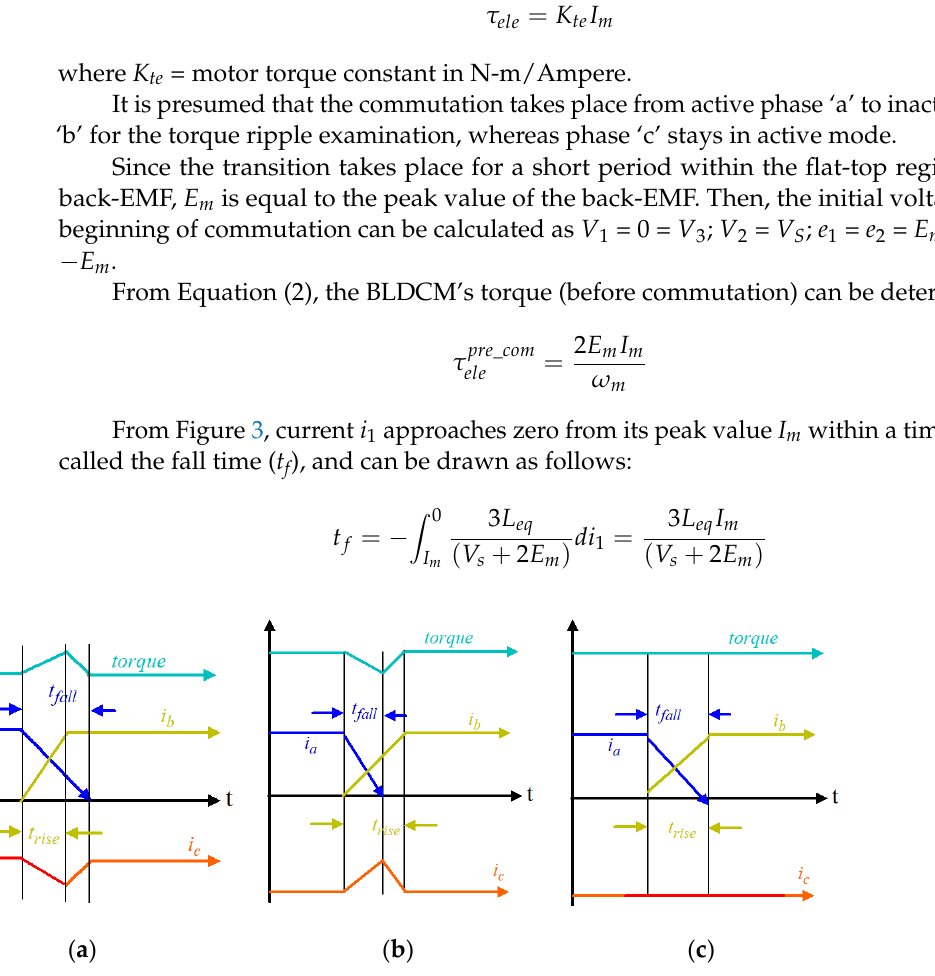
Figure 3. Characteristic of phase current during the commutation: ( a ) positive torque ripple (i.e., t fall > t rise ); ( b ) negative torque ripple (i.e., t fall < t rise ); and ( c ) zero torque ripple (i.e., t fall = t rise ).